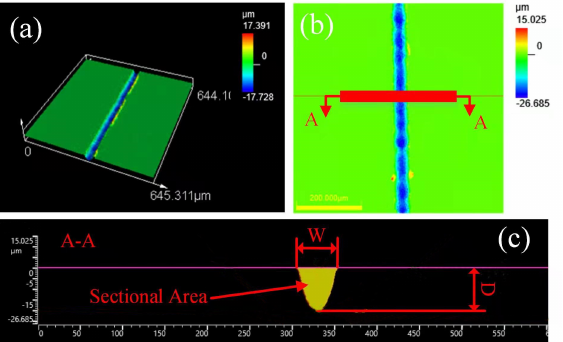
Figure 2. Typical micro-groove structure. ( a ) Axonometric view of micro-groove. ( b ) Top view of micro-groove. ( c ) Sectional view of micro-groove.